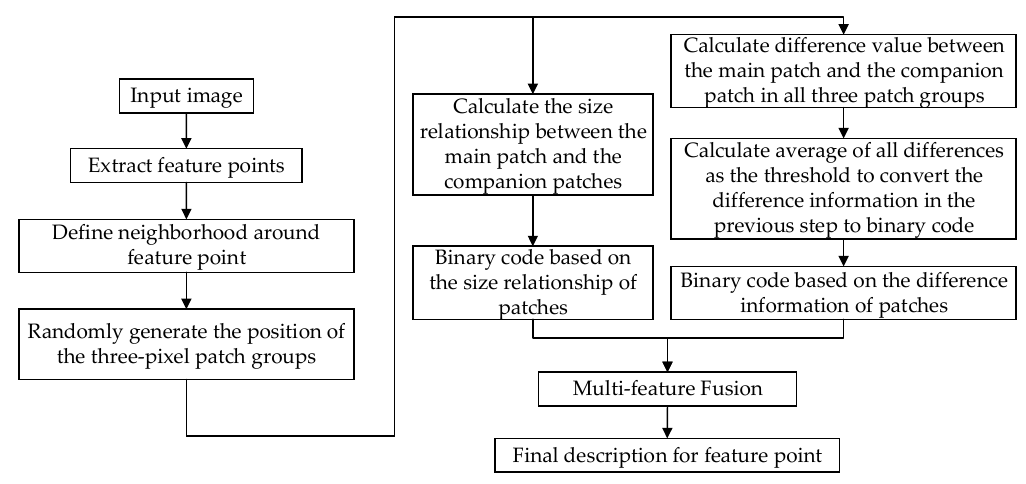
Figure 4. Final description process proposed in this paper.